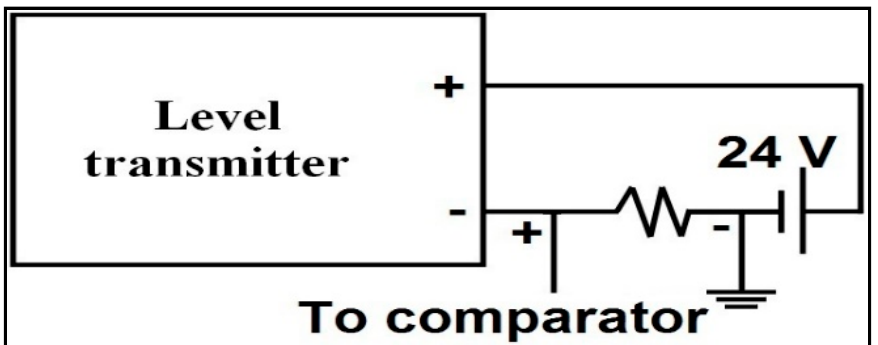
Figure 8. Conversion of the output current of the transmitter into voltage.